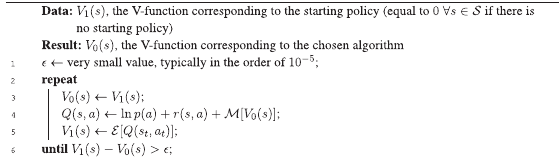
Algorithm 1. Algorithm for the generic V-function